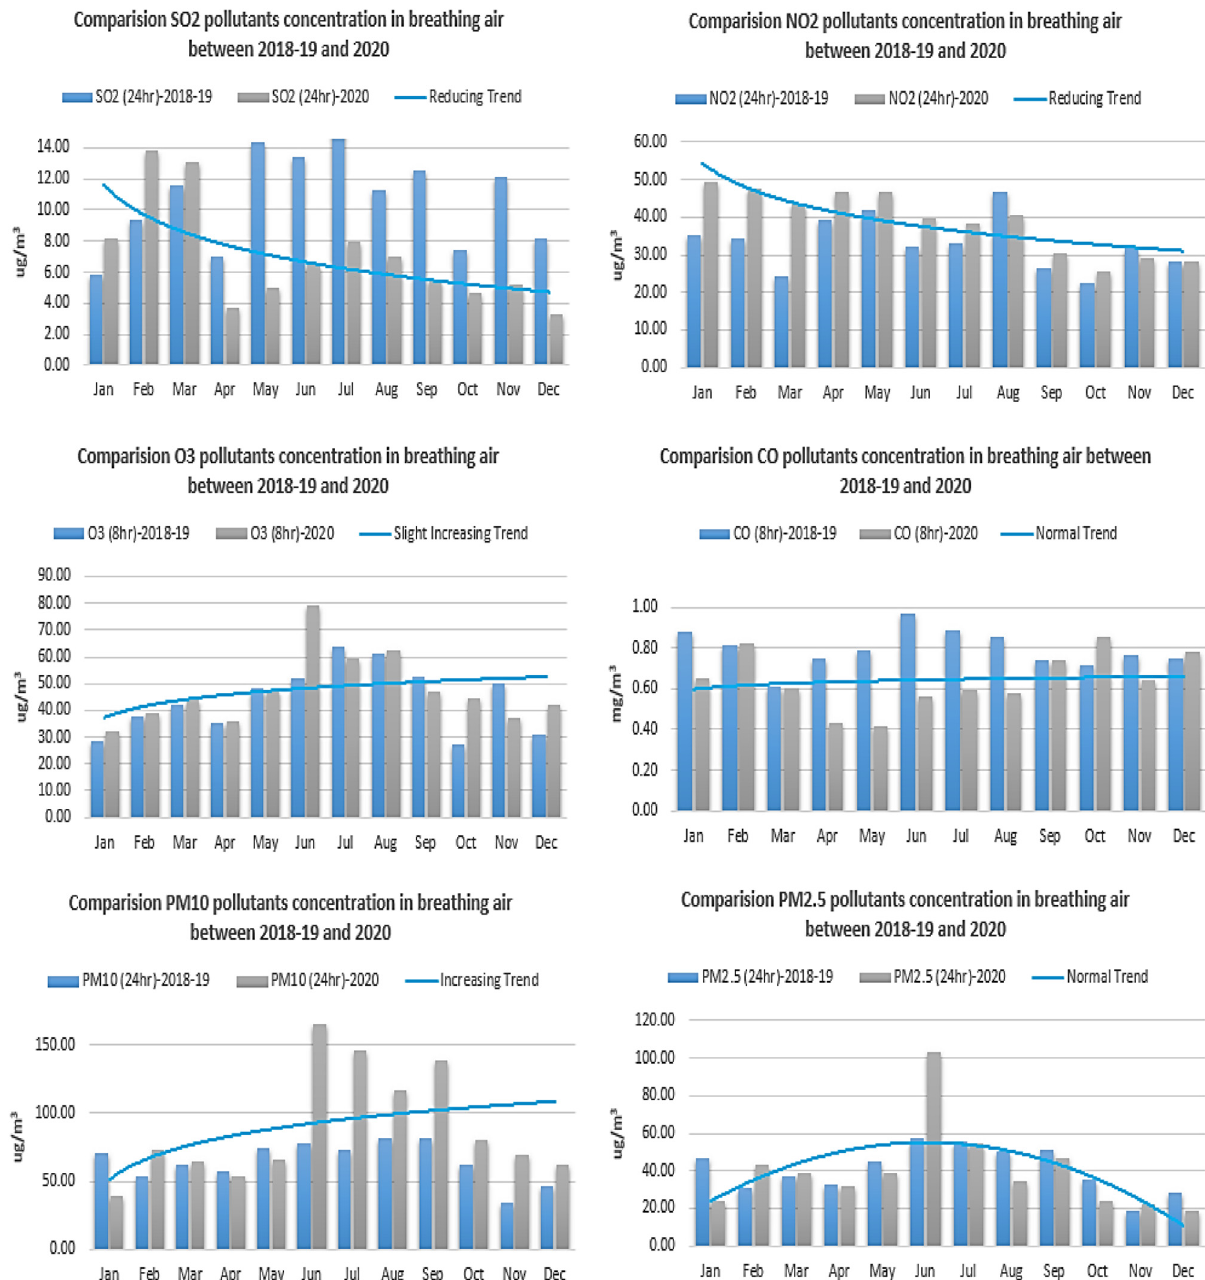
Fig. 6. Air quality data collected for the period between 2018 – 2020 [24] (see Supplementary